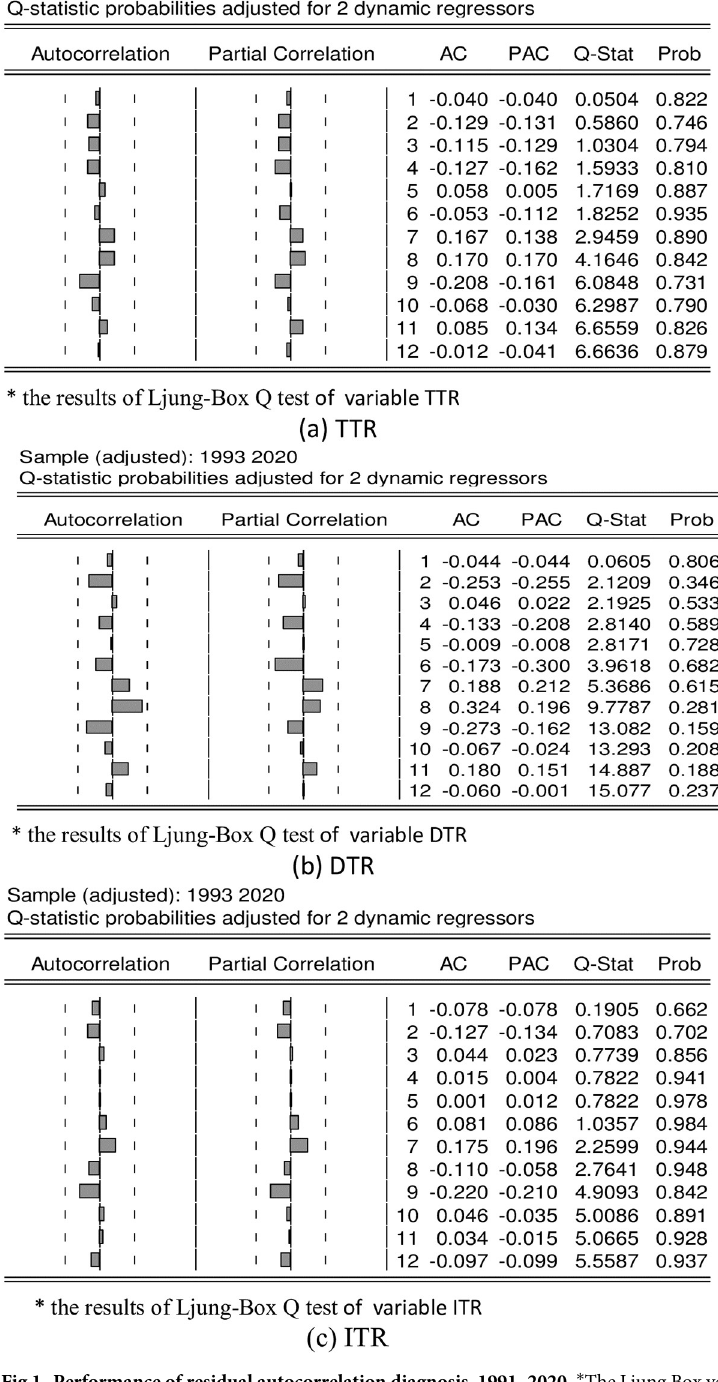
Fig 1. Performance of residual autocorrelation diagnosis, 1991–2020. * The Ljung Box verification results can be seen from Fig 1(a)-1(c), the Ljung Box test statistics from Phase 1 to Phase 12 were all 5% higher than the significant level, indicating that there was no self correlation between the residual items of Phase 1 and Phase